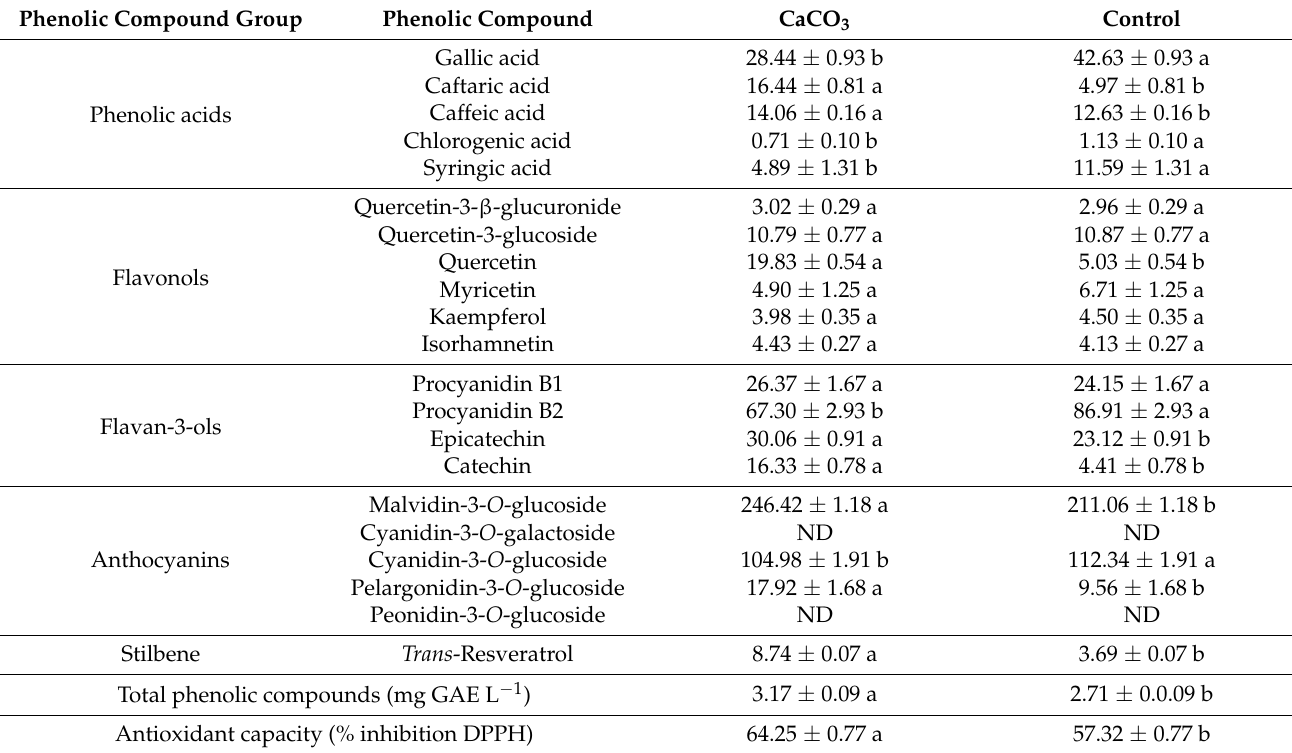
Values represent the mean of four individual measurements ± standard error. Values in the same row with different letters are significantly different ( p < 0.05). ND, not